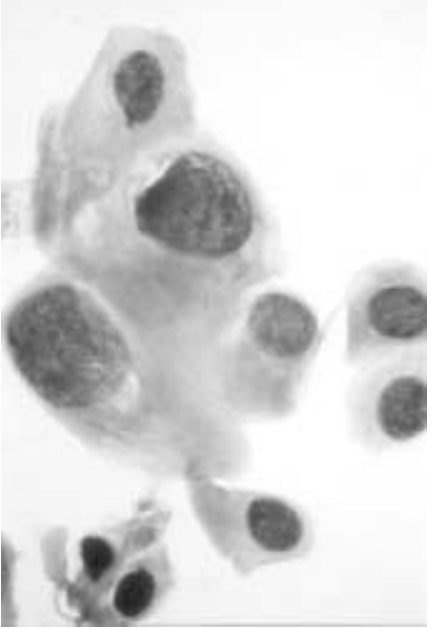
Fig. 4. Brushing smear obtained months after MMC-treatment of a carcinoma in situ of the conjunctiva showing drug-associated anisonucleosis of non-neoplastic squamous cells. Magnification 63 ×